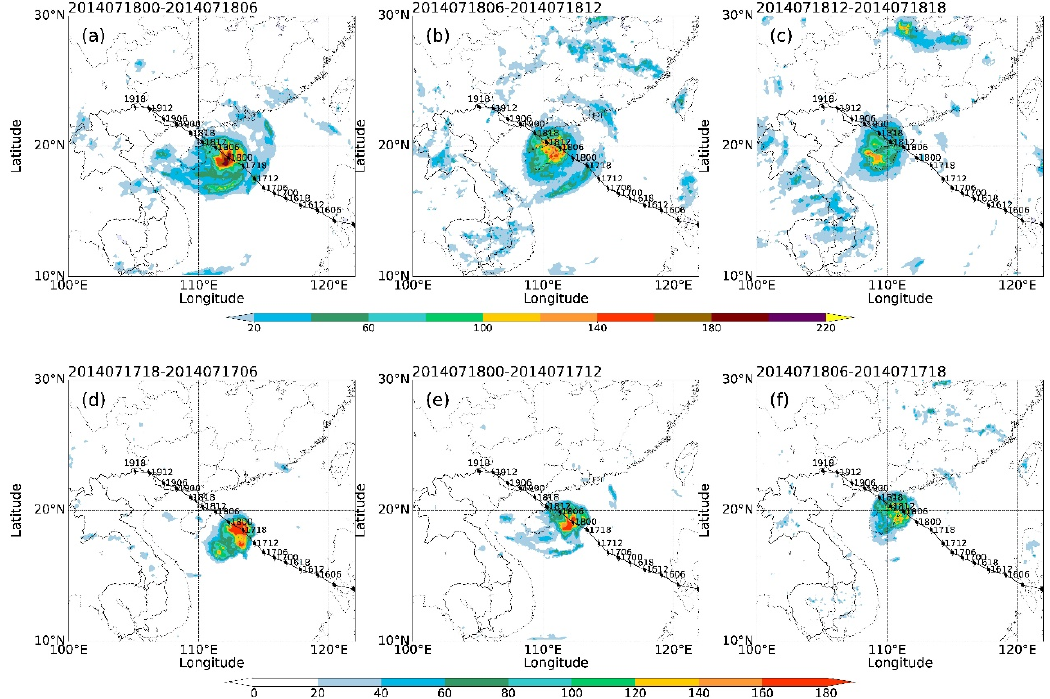
Figure 2. The 6 h accumulated precipitation (shading, unit: mm) and tracks of Rammasun ( a ) from 00 UTC to 06 UTC 18 July, ( b ) from 06 UTC to 12 UTC 18 July, and ( c ) from 12 UTC to 18 UTC 18 July; this is the same as ( a – c ) but for rainfall difference (shading, unit: mm) of Rammasun ( d ) between the precipitation from 18 UTC 17 July to 00 UTC 18 July and that from 06 UTC to 12 UTC 17 July, ( e ) between the precipitation from 00 UTC to 06 UTC 18 July and that from 12 UTC to 18 UTC 17 July, and ( f ) between the precipitation from 06 UTC to 12 UTC 18 July and that from 18 UTC 18 July to 00 UTC 19 July.